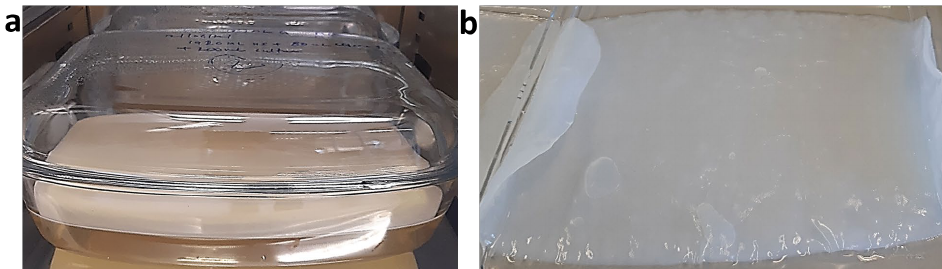
Figure 3. ( a ) BC produced under the static conditions in Professor Roy’s laboratory, University of Sheffield, using the bacterial strain K. xylinus , ( b ) Purified